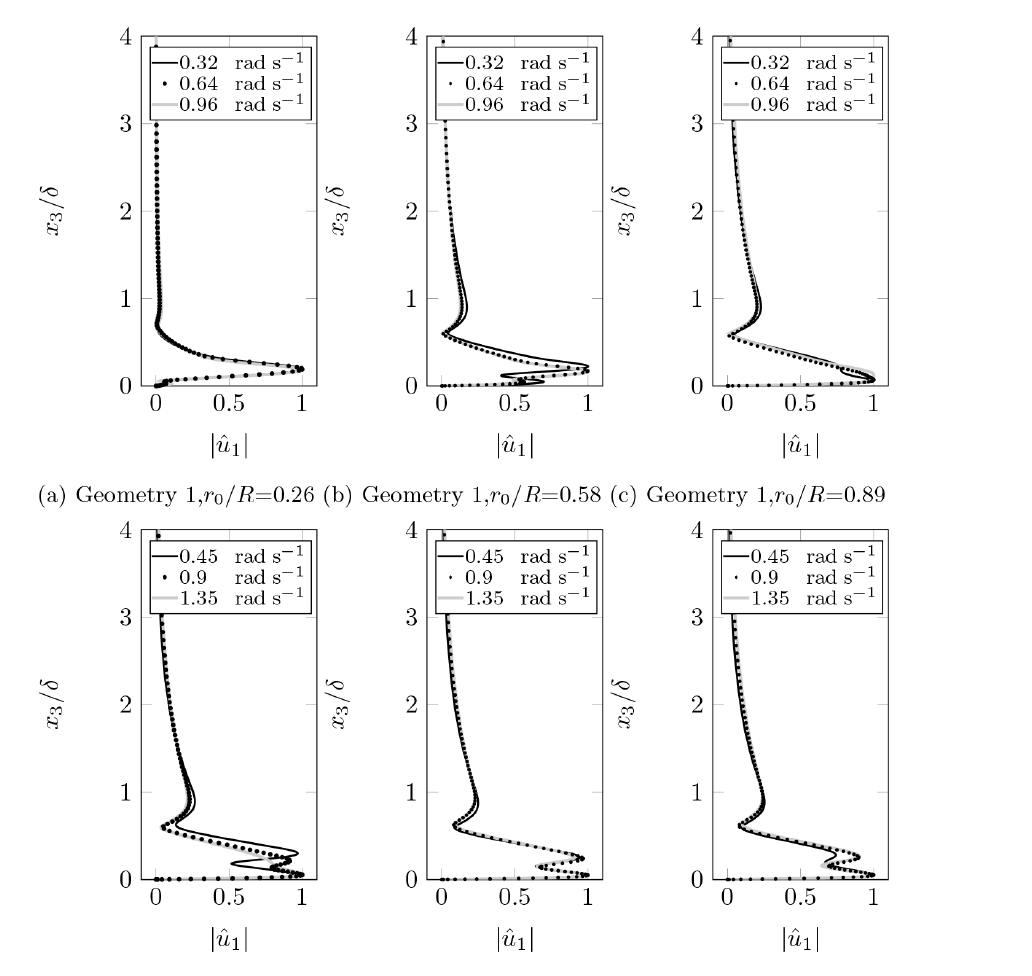
Figure 16. PSEX results for the mode leading to transition for several rotation speeds.